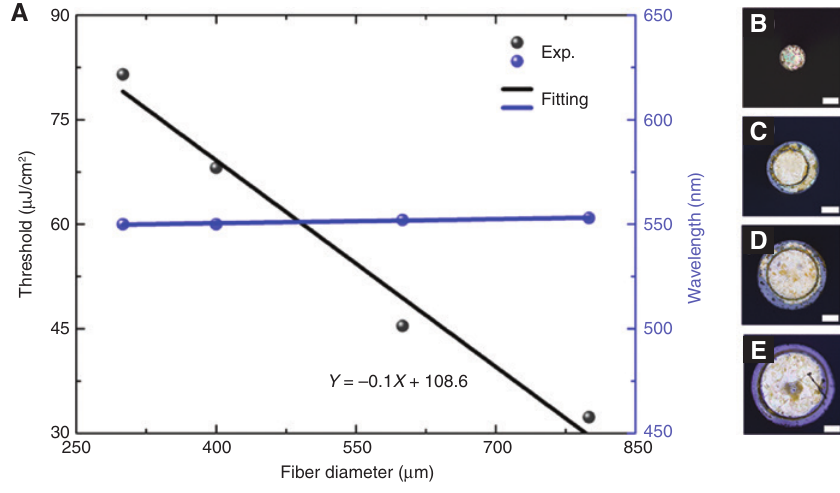
Figure 4: Thresholds of different random lasers. (A) Threshold and wavelength of the random lasers as a function of the fiber diameter. (B–E) Microscope images of optical fibers with diameters 300, 400, 600, and 800 μ m, respectively. The scale bar is 200 μ